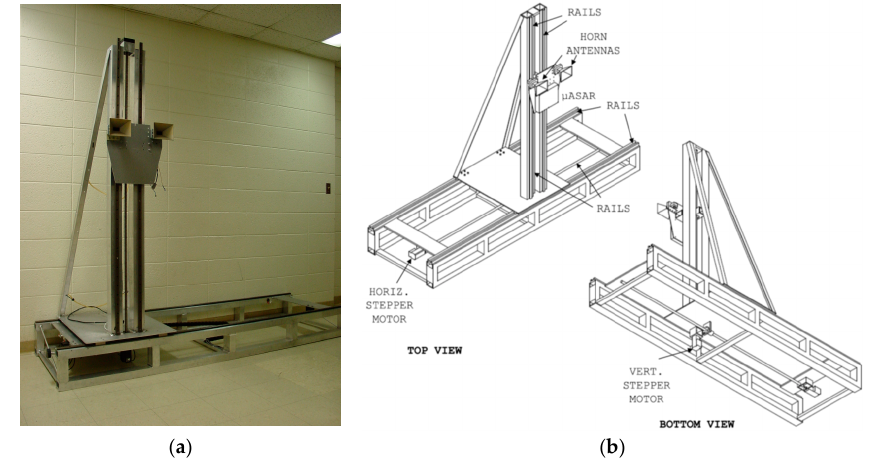
Figure 5. ( a ) Photo of the 2D scan mechanism. The C-band transmit and receive horns are visible at the top of the moving platform on which the microASAR [2] is mounted during operation. The scanner has approximately 1.7 m vertical and horizontal displacement that is computer controlled; ( b ) drawings detailing the mechanical structure of the scanner. Stepper motors are computer controlled from a laptop computer. Digitized radar data is time-tagged with the scanner position.